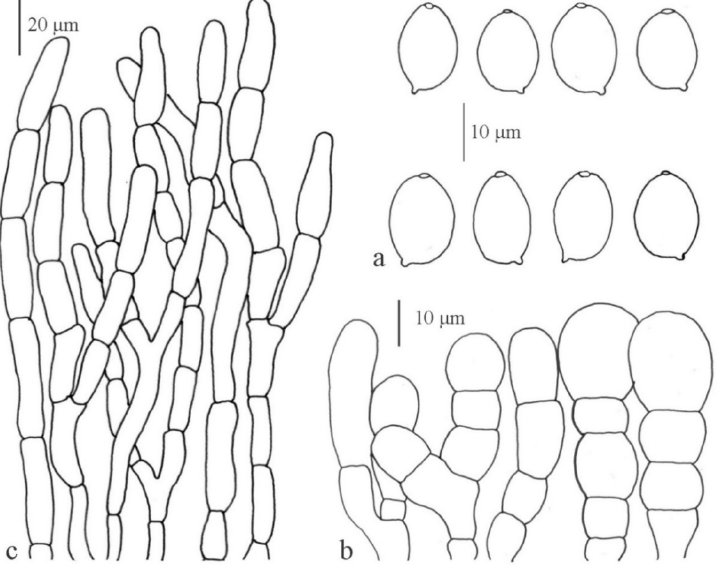
Figure 20. Microcharacters of Macrolepiota excelsa (ecv3572, Type). ( a ) basidiospores. ( b ) Cheilocys- tidia. ( c ) pileus covering.